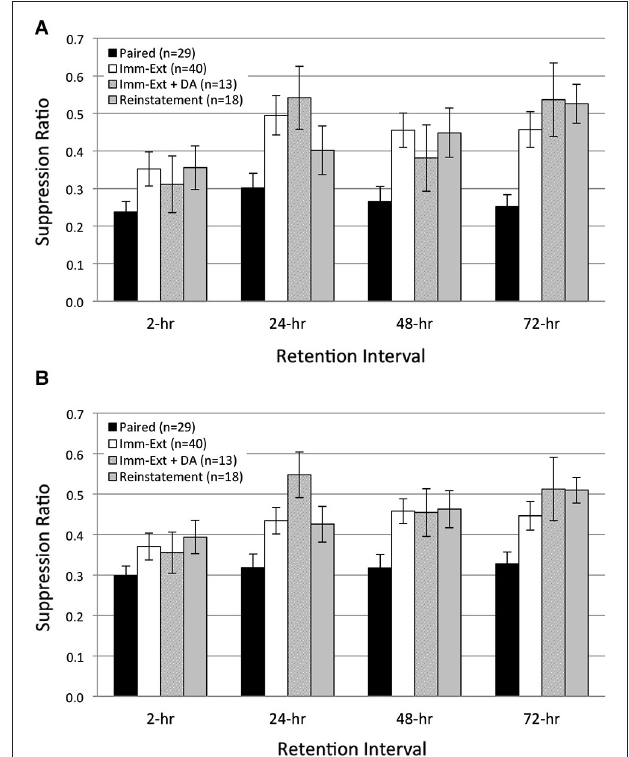
FIGURE 4 | Additional rotation stimuli failed to reinstate extinguished phototactic suppression. Average start (A) and finish (B) latency suppression ratio (SR) scores measured at four different RIs post-acquisition. Animals ( Reinstatement group) given extinction training followed by five additional rotation stimuli prior to the 2-h RI, and another five rotation stimuli prior to the 24-h RI, did not show reinstatement of extinguished phototactic suppression produced by paired conditioning. Reinstatement animals exhibited phototactic behavior that was indistinguishable from animals given immediate extinction training ( Imm-Ext group) at all four RIs for both start (A) and finish (B) latency behavior. This result was also found when controlling for the additional 15 min period of dark adaptation given to Reinstatement animals; SR scores for Immediate Extinction animals given extra dark adaptation ( Imm-Ext + DA group) were no different from Reinstatement group SR scores for both start (A) and finish (B) latency behavior. Error bars are ±